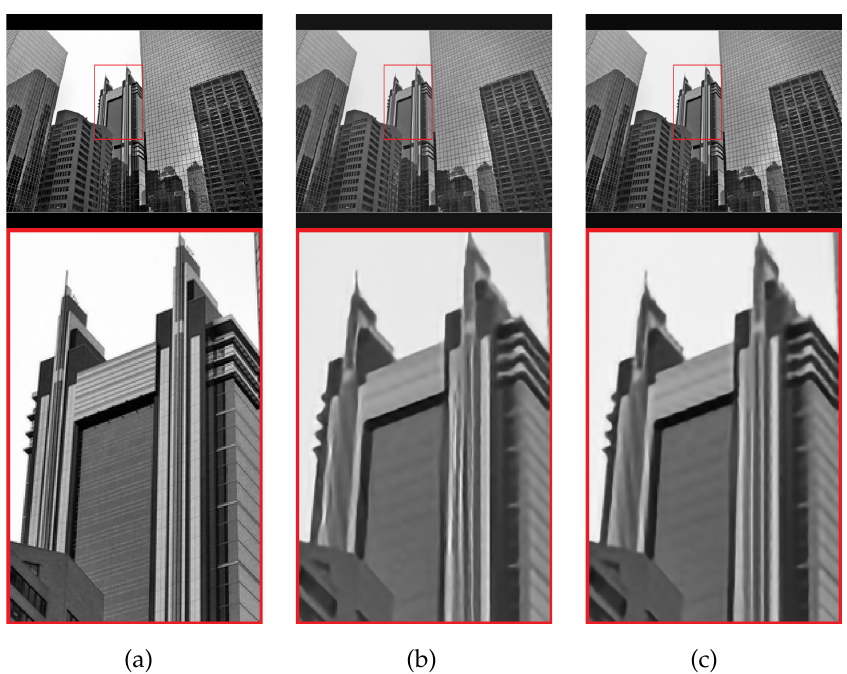
Figure 7. Super-resolution image reconstruction results. ( a ) Ground truth image. ( b ) The result of the VDSR method (PSNR = 23.93 dB). ( c ) The result of the proposed method (PSNR = 24.20